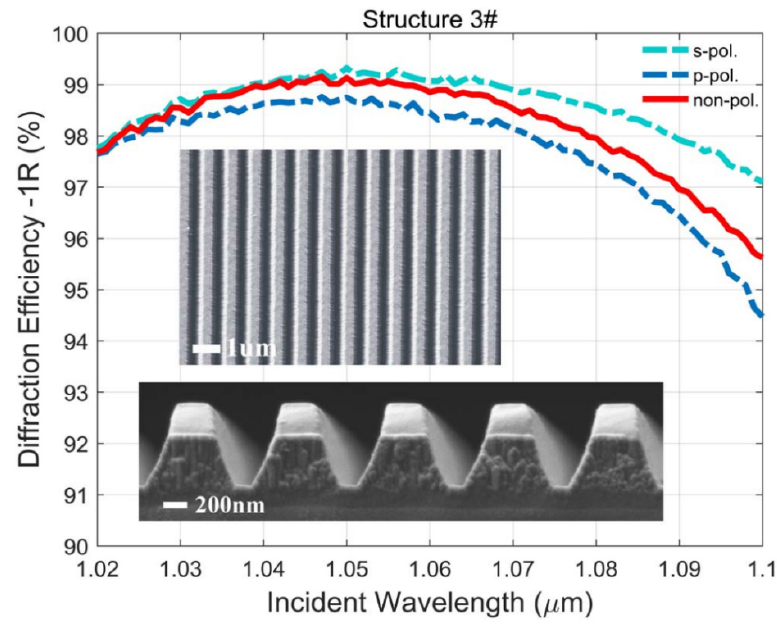
Figure 18. SEM image of a multilayer-dielectric-film reflection grating and a − 1 order polarization-independent diffraction-efficiency spectrum.